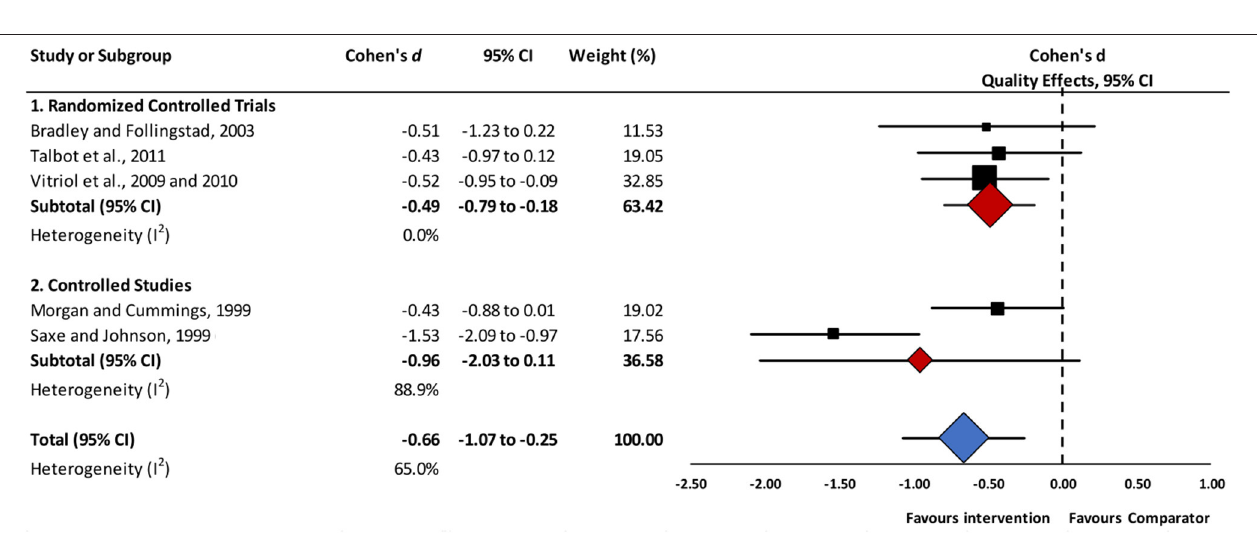
depressive symptoms, which was a combined